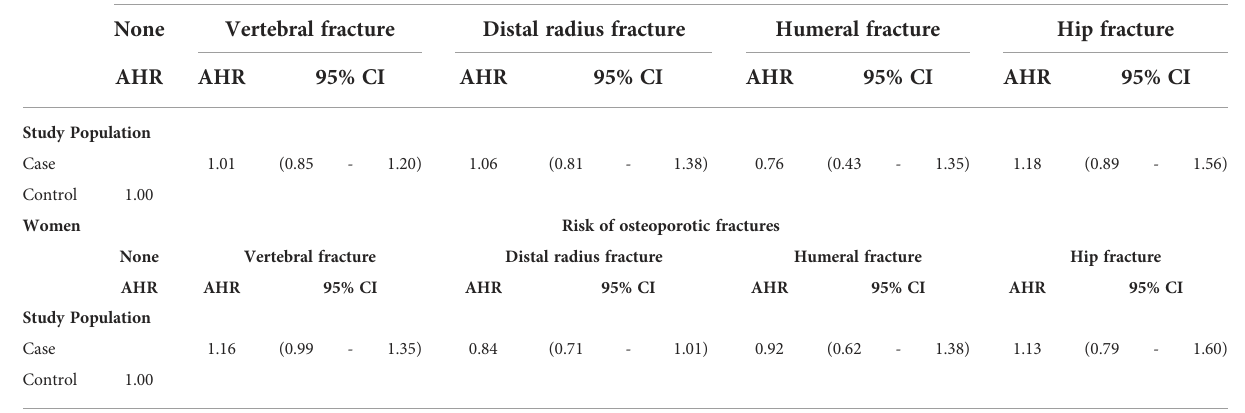
TABLE 3 Results of subgroup analysis strati fi ed by osteoporotic fractures site.